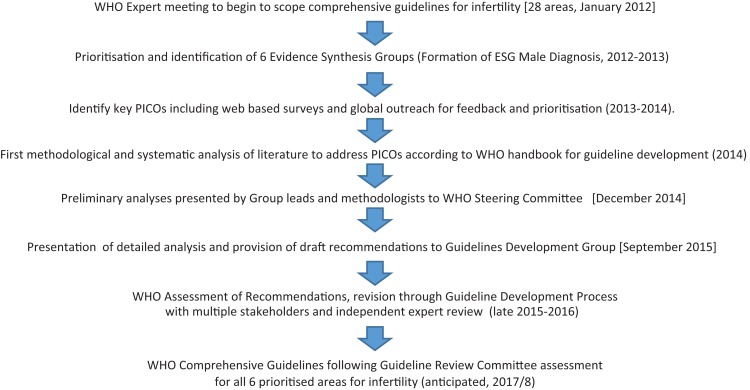
Outline flowchart of WHO methodology for ESG Male Diagnosis. Flowchart outlining the WHO process for obtaining the evidence, and formulating and presenting recommendations for male infertility (Diagnosis). This includes stages and methods for synthesis of evidence according to WHO process. Dates in square bracket reflect specific meetings at WHO in Geneva. PICO: problem or population (P), intervention (I), comparison (C) and outcome(s) (O). WHO, World Health Organization; ESG, Evidence Synthesis Group.